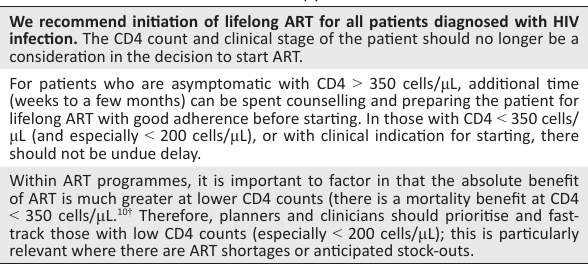
Box 1: Indications for antiretroviral therapy in adults with HIV infection. We recommend initiation of lifelong ART for all patients diagnosed with HIV infection. The CD4 count and clinical stage of the patient should no longer be a consideration in the decision to start